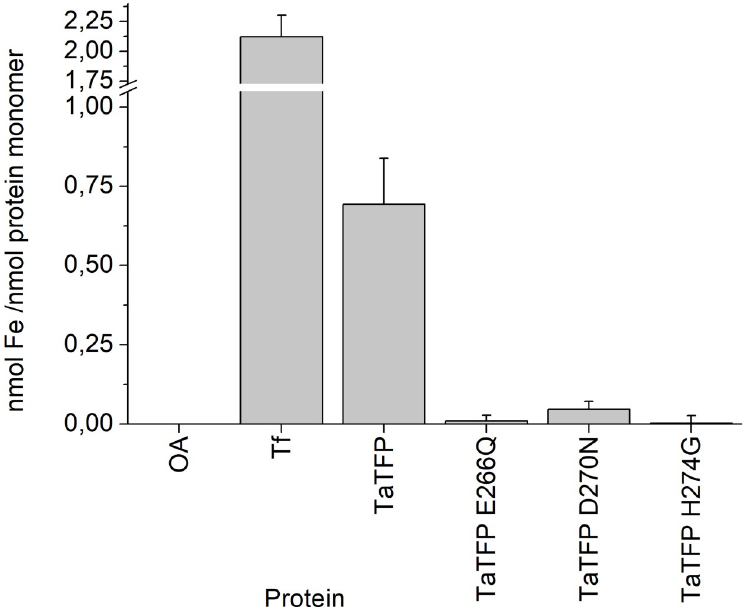
Fig 3. ICP-MS quantification of iron in TaTFP wildtype and mutants. Proteins (in 37.5 mM sodium acetate buffer, pH 5, with 6.25% (w/v) sucrose) were denatured and precipitated. The supernatant was subjected to ICP-MS. Iron was quantified based on calibration with Iron ICP Standard. OA, ovalbumin; Tf, holo-transferrin. Shown are means ± SD (N = 3 independent expression experiments).